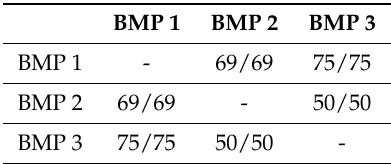
Table 18. Test results for similar BMP images with